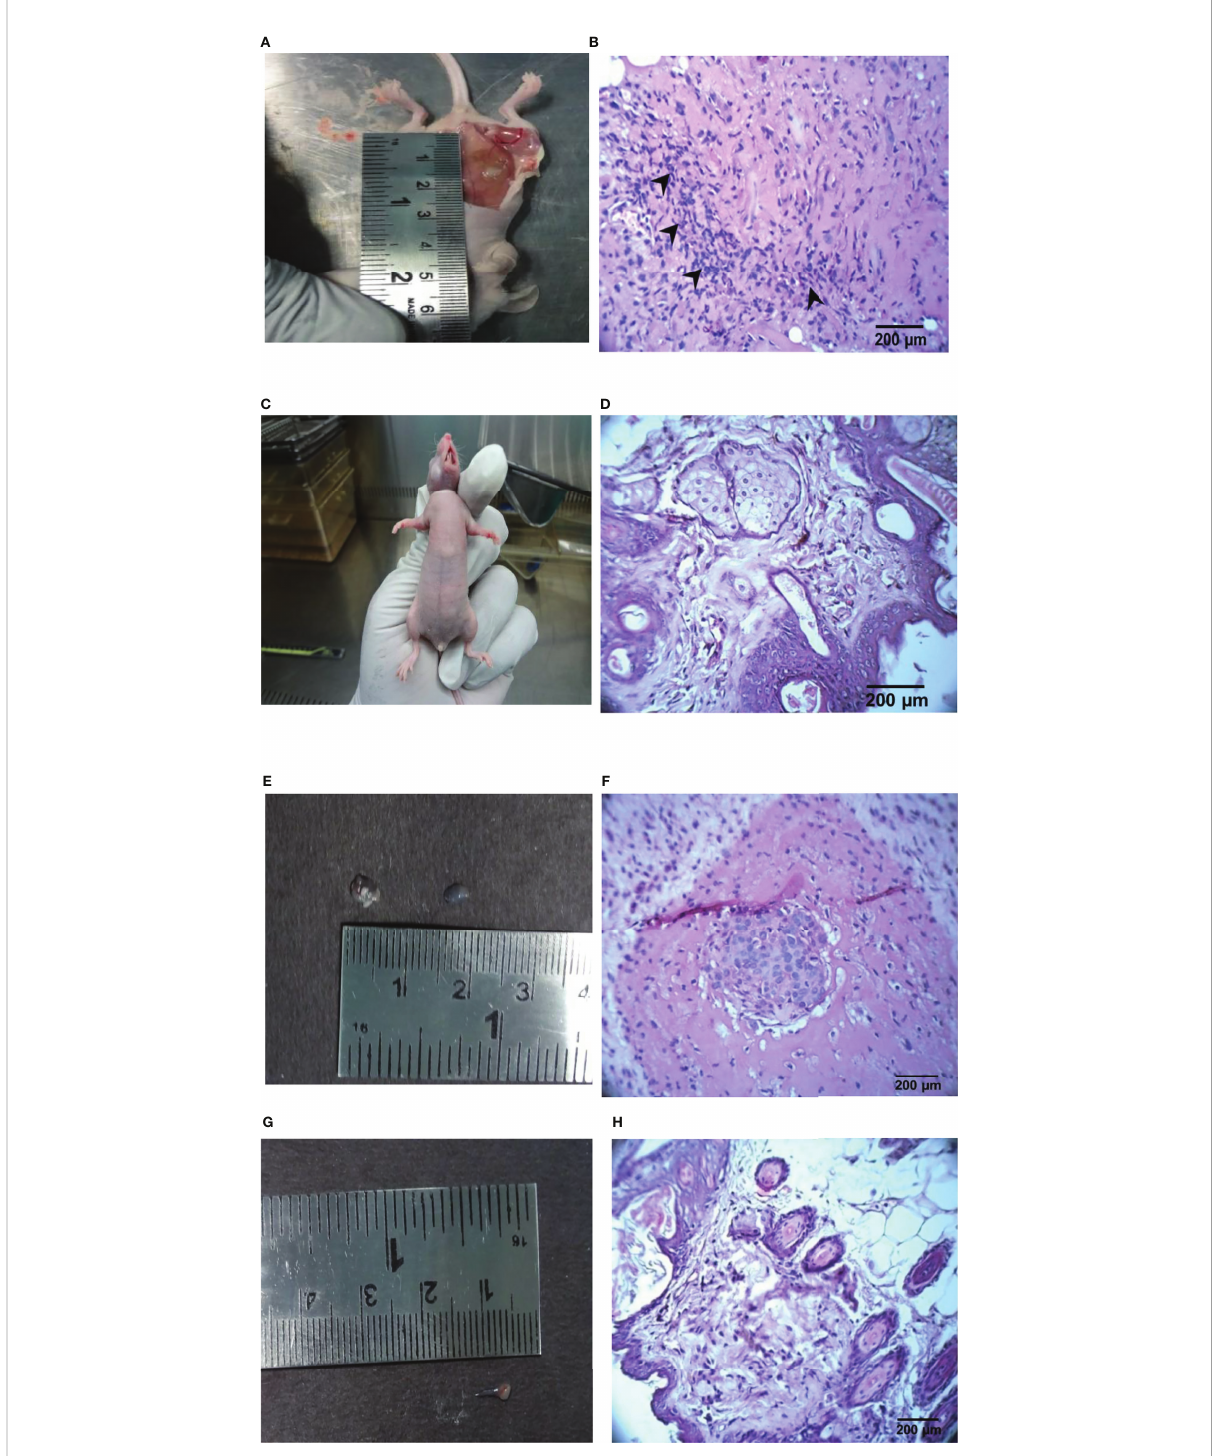
FIGURE 5 Representative images of the control, ethyl acetate extract, doxorubicin-treated tumor and its histopathology fi ndings in athymic mice. (A) Control mice with vehicle, (B) Control mice tumor (H & E, 400 X), (C) Doxorubicin-treated (1 mg/kg), (D) Doxorubicin-treated skin (H & E, 400X), (E) Ethyl acetate extract-treated (100 mg/kg b.wt.), (F) Ethyl acetate extract of Spirastrella pachyspira -treated (100 mg/kg b.wt.) (H & E, 400 X), (G) Ethyl acetate extract of Spirastrella pachyspira -treated (200 mg/kg b.wt.), (H) Ethyl acetate extract of Spirastrella pachyspira -treated (200 mg/kg b.wt.) (H & E, 400